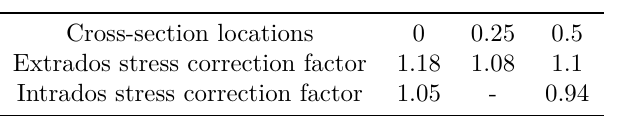
Table 2. The 3D/2D correction factors for the compressive stresses at three cross-section